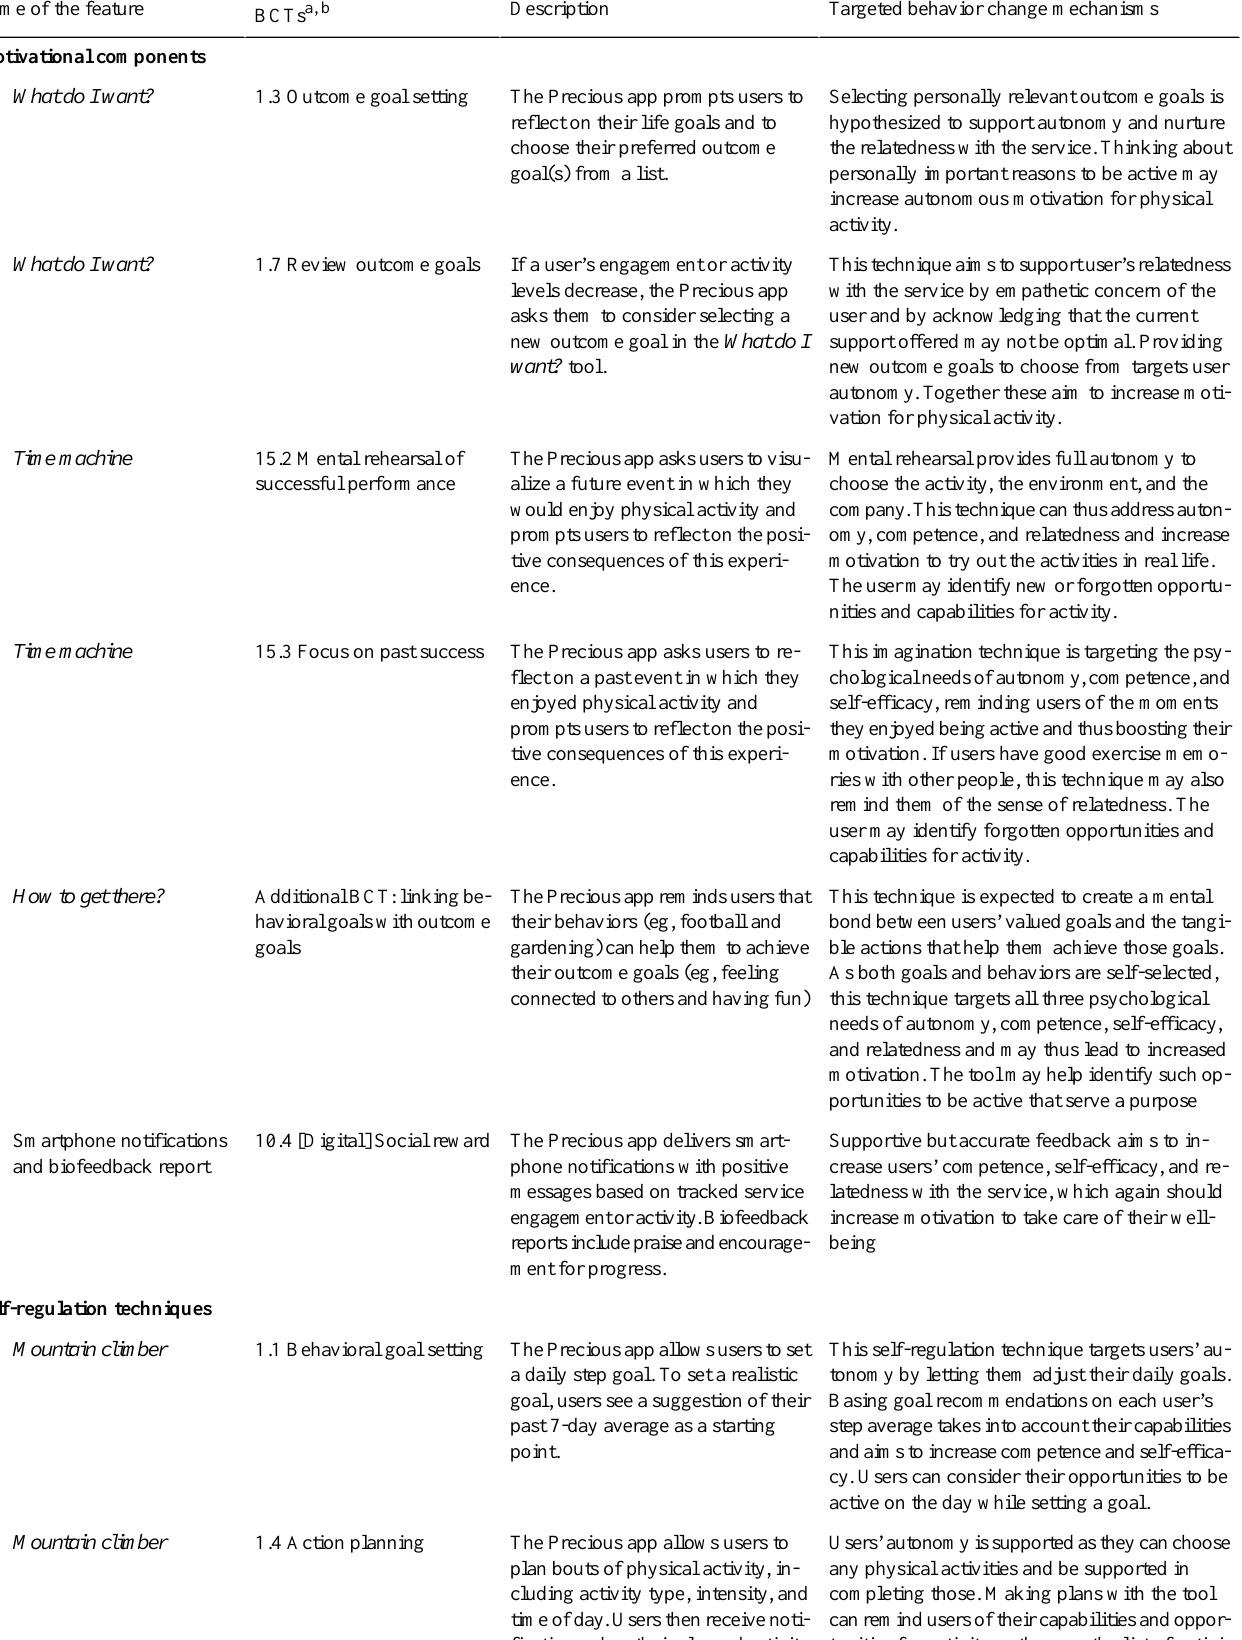
Targeted behavior change mechanismsDescriptionBCTs a, b Name of the feature